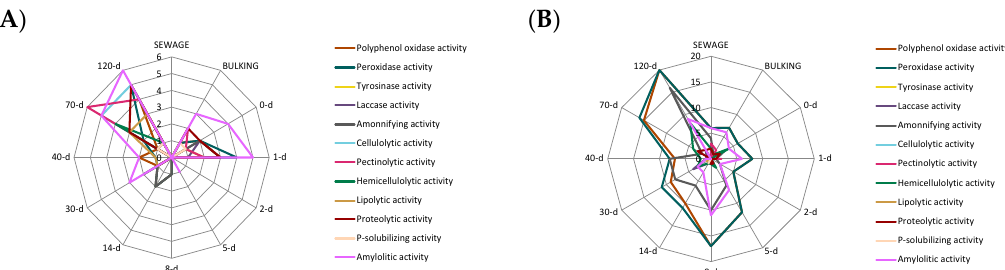
Figure 2. Number of extracellular enzymes produced by fungal ( A ) and bacterial ( B ) isolates in each composting sample.